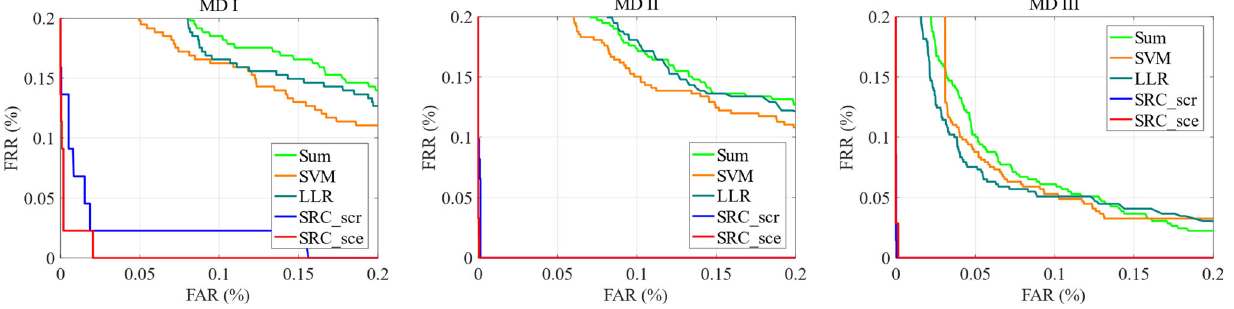
Fig. 12 ROC curves of all the multimodal methods using CNN features on MD I, MD II, and MD